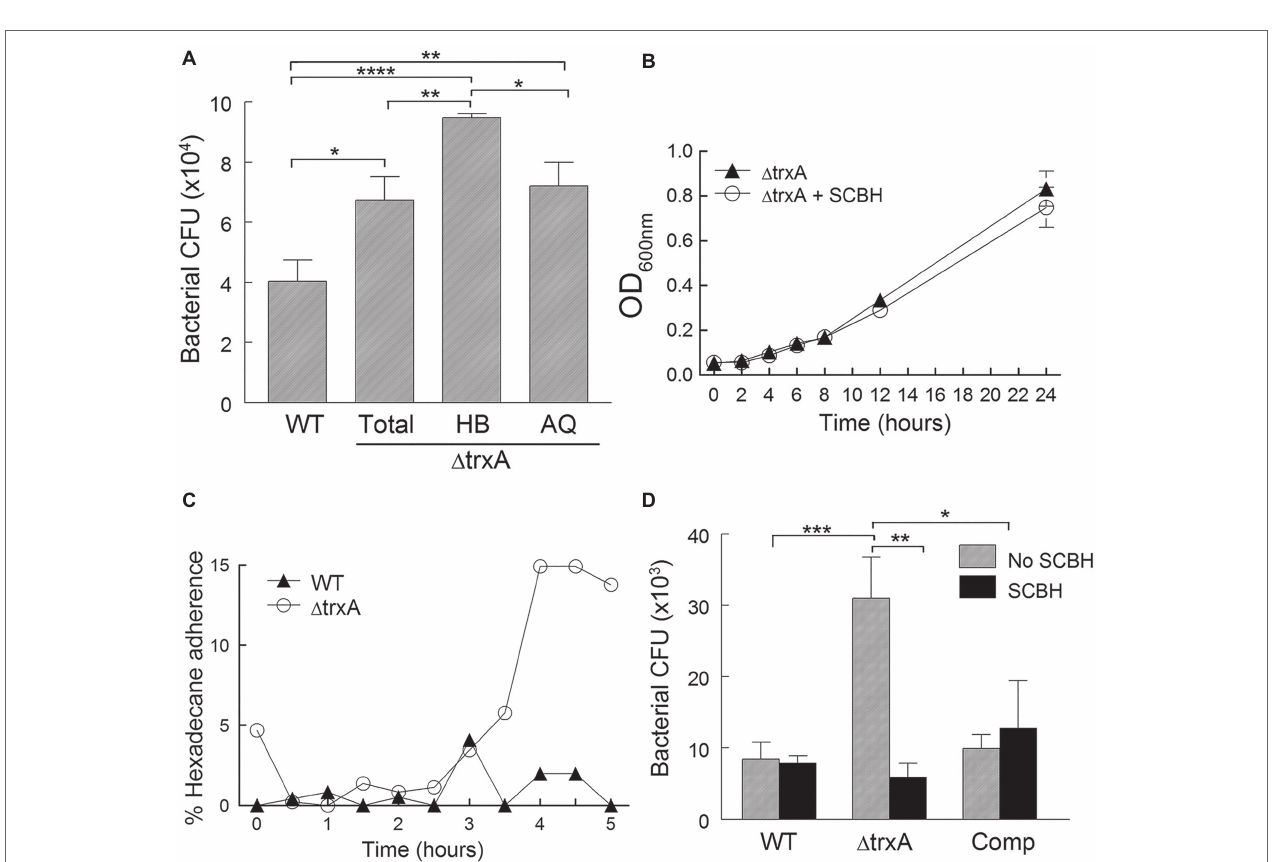
FIGURE 3 | Bacterial cell surface hydrophobicity modulates phagocytosis. (A) Recovered CFU/well of bacteria phagocytosed by J774 cells from WT, Δ trxA (Total), Δ trxA (HB) hydrophobic partition, and Δ trxA (AQ) aqueous partition. (B) Bacterial growth in the presence of sodium cyanoborohydride (SCBH). (C) Time course of the retention of bacterial hydrophilicity after SCBH treatment. (D) Recovered CFU/well of bacteria, with or without SCBH treatment, following phagocytosis (1-h bacterial uptake followed by 2-h antibiotic treatment) by J774 cells. Statistical differences were determined by one-way (A) and two-way (D) ANOVA with Holm-Sidak correction for multiple comparisons (**** p < 0.0001; *** p < 0.001; ** p < 0.01; * p <